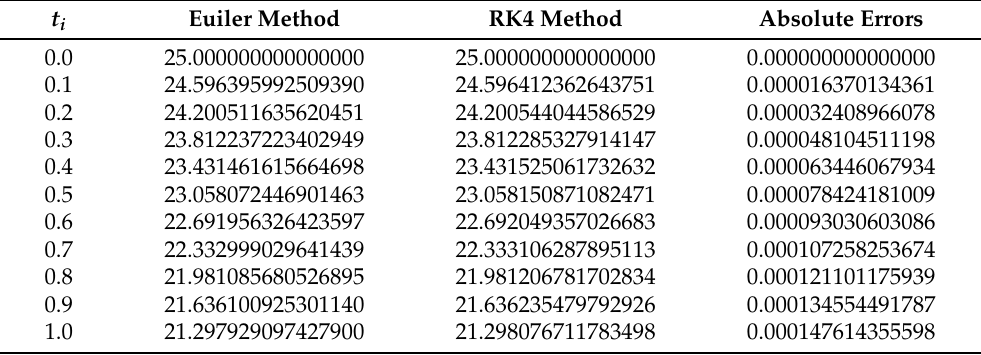
Table 7. Comparison between the results of the modified Euler method and RK4 method for V ( t ) .